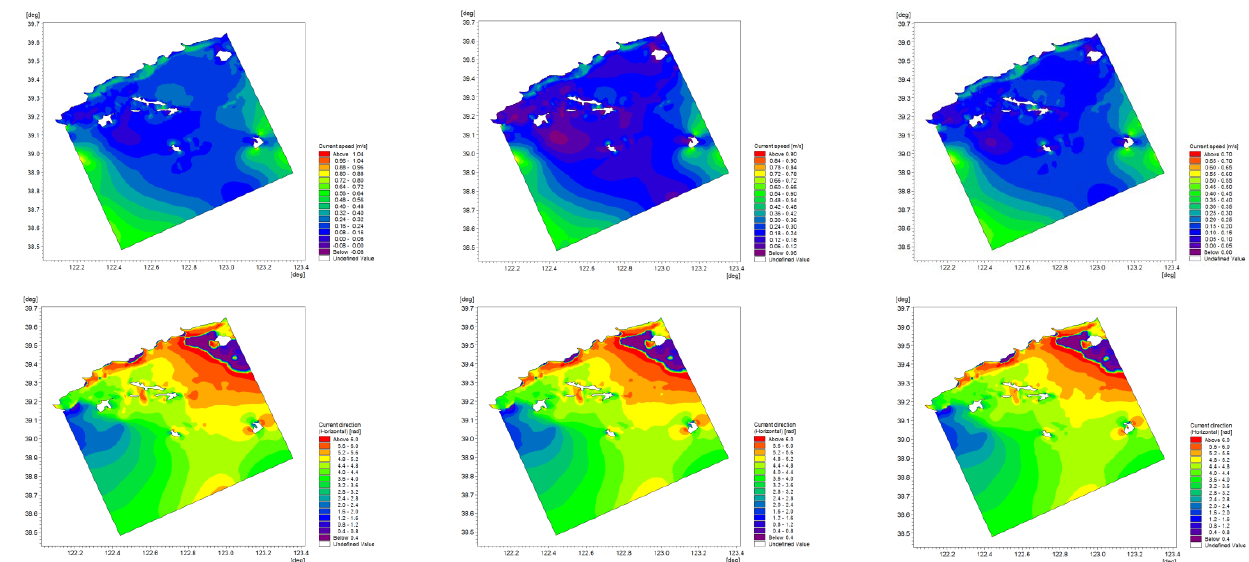
Figure 6. Verification of flow rates and directions at P1 and P2.